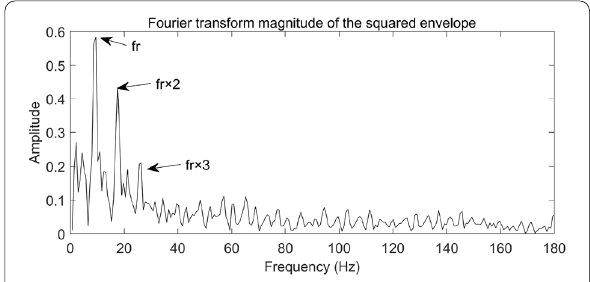
Figure 18 Squared envelope spectrum of the processed tooth broken signal based on the proposed